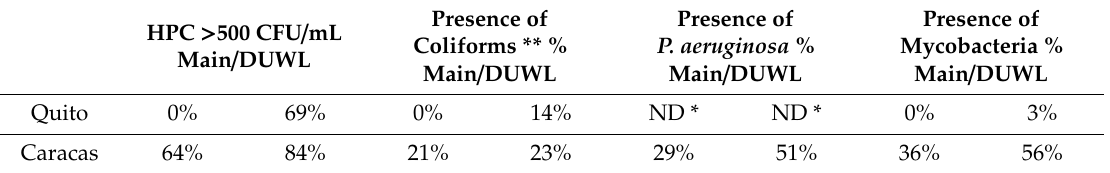
Table 1. Presence of bacteria in the mains and dental unit waterlines (DUWLs) in Quito and